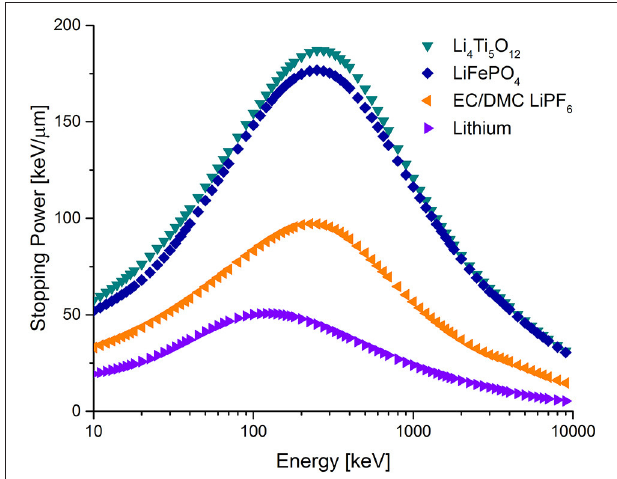
FIGURE 3 | Selected stopping powers. The transition metal insertion hosts have twice as high stopping compared the commonly used EC/DMC electrolyte, which in turn is almost twice as high as metallic